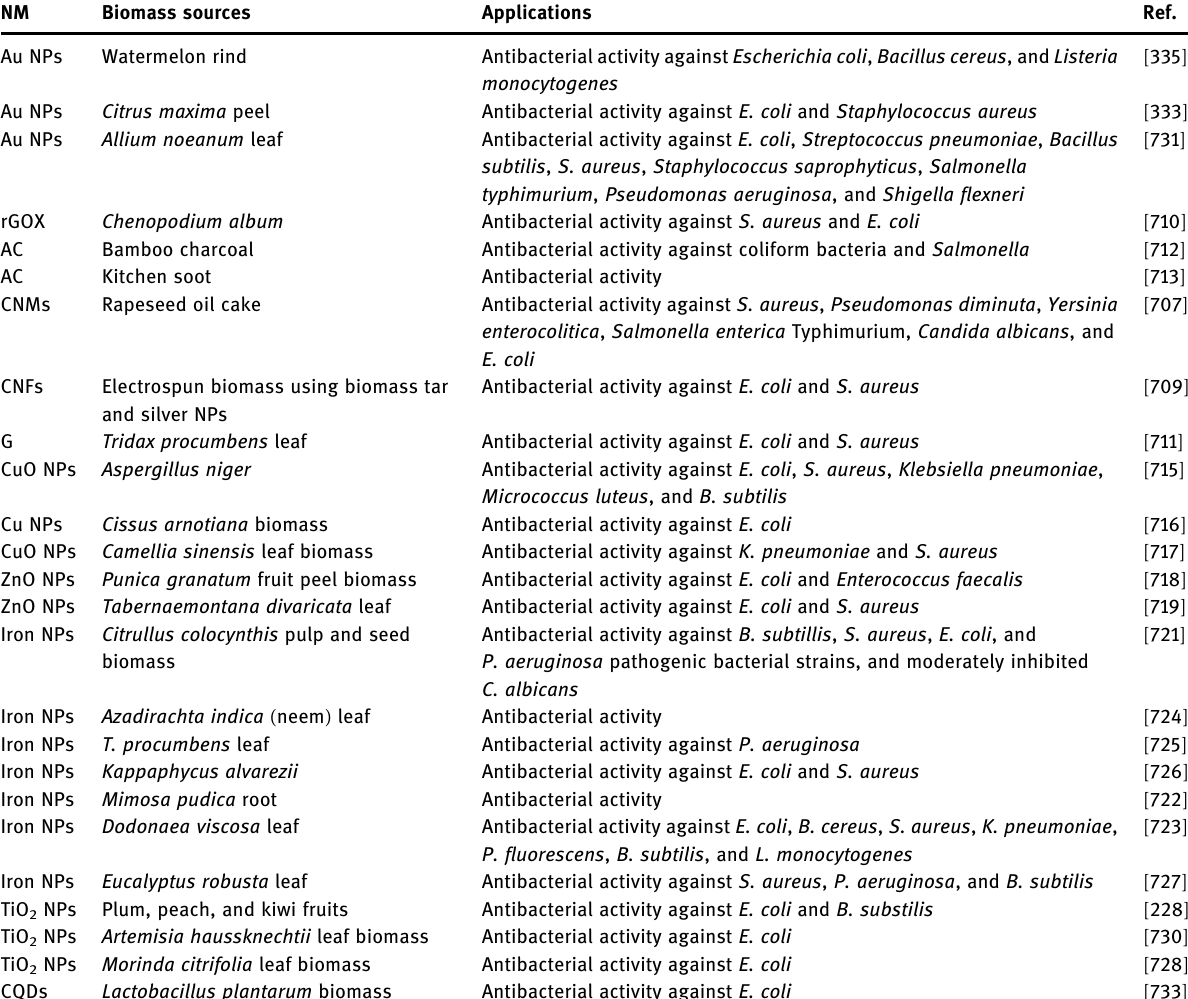
Table 14: Application of recycled NPs as therapeutic antimicrobial